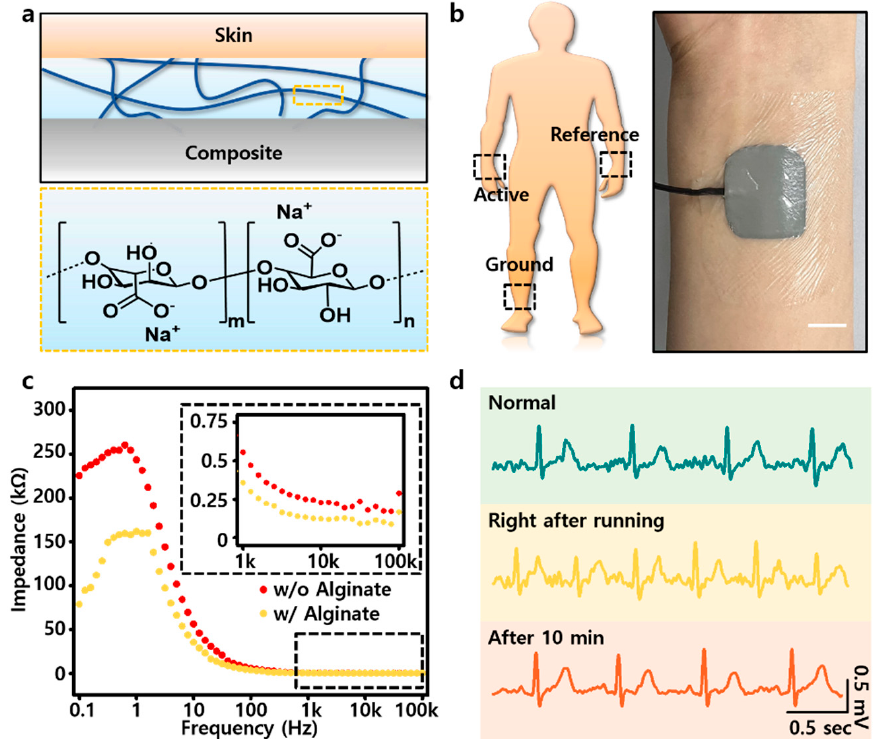
Figure 4. ( a ) Schematic of three layers when EATE is attached to the skin ( top ) and chemical structure of alginate ( bottom ). ( b ) Schematic of electrode positioning for ECG monitoring ( left ) and photograph of EATE (scale bar: 1 cm). ( c ) Impedance of the EATE and EATE without alginate hydrogel (only EGaIn-SEBS composite). ( d ) Real-time ECG signal monitoring before and after running.